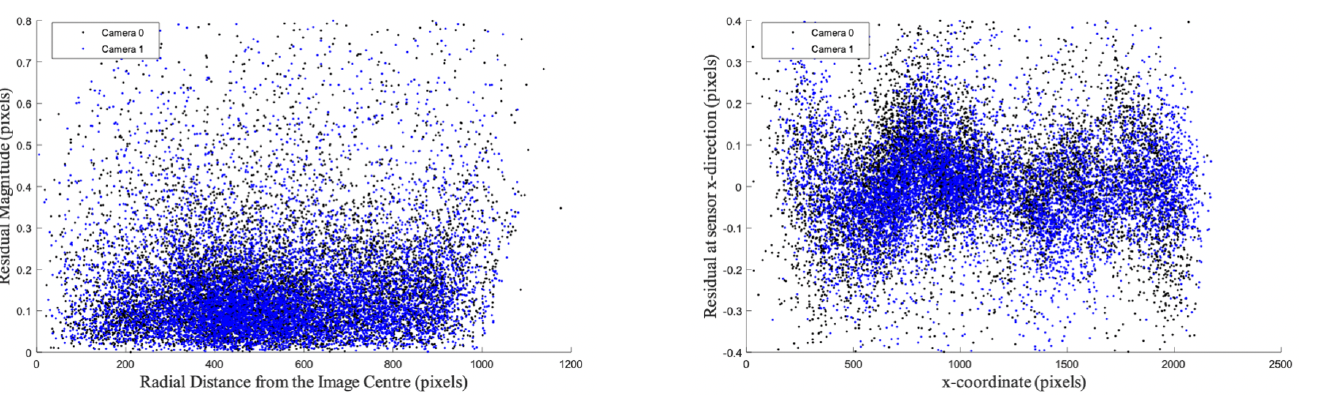
Figure 12. Unmodelled systematic errors in the residuals using the photogrammetric model, including five radial lens distortion coefficients described in Equation (7). ( Left ) The magnitude of the residuals versus the radial distance of the observations from the image center. ( Right ) The x-component of the residuals versus the x coordinate of the observations.